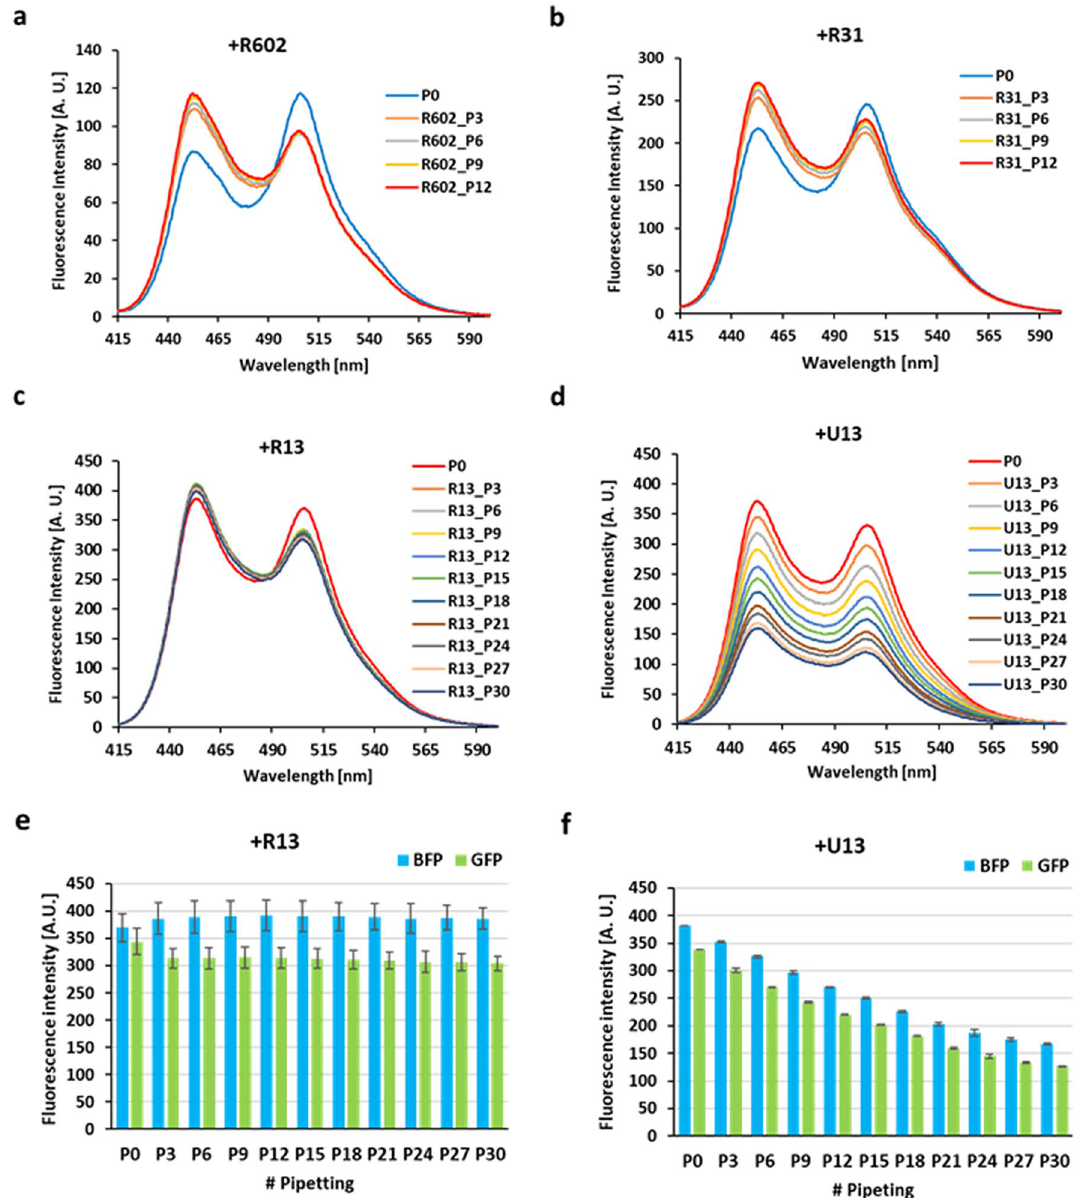
Figure 4. Sequence-dependent suppression of aggregation of FUS by RNA. ( a – c , e ) The fluorescence spectrum of 100 nM FUS fusion protein (MBP-BFP-FUS-GFP-6xHis) without pipetting is shown in blue (P0). An equimolar amount of either the full-length pncRNA (R602) ( a ), R31 ( b ), R13 ( c ), or U 13 ( e ) was added to the protein solution. Then, fluorescence spectra were measured after every three stokes of pipetting: cumulative numbers of strokes are indicated, e.g., R602_P6 for six cumulative strokes of pipetting after the addition of R602 RNA. ( d ) A bar graph for BFP and GFP fluorescence intensities, at 453 and 506 nm, respectively, of the fluorescence spectra shown in ( c ). ( f ) The similar bar graph of the fluorescence spectra shown in ( e